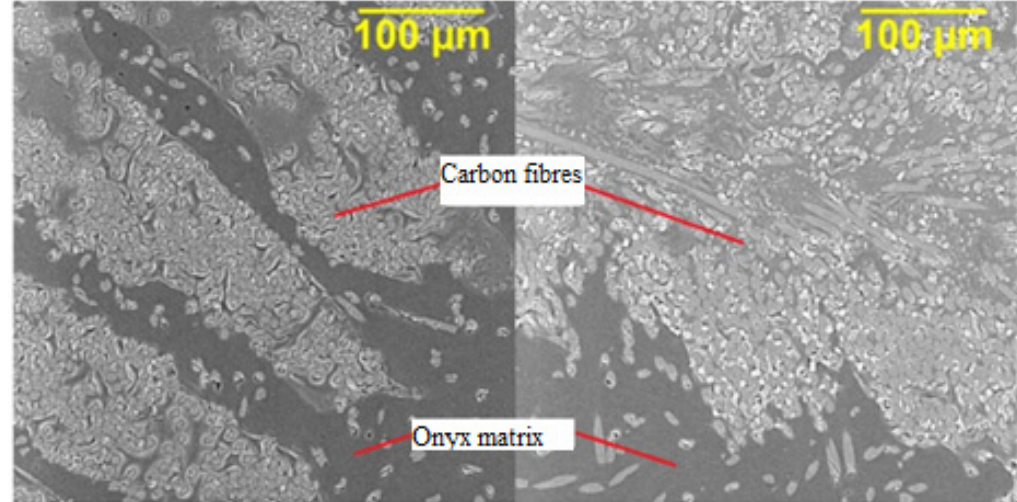
Figure 10. SEM analysis; microstructure of CFRP/onyx produced by 3D printing. Undeformed sample ( left ), deformed sample ( right